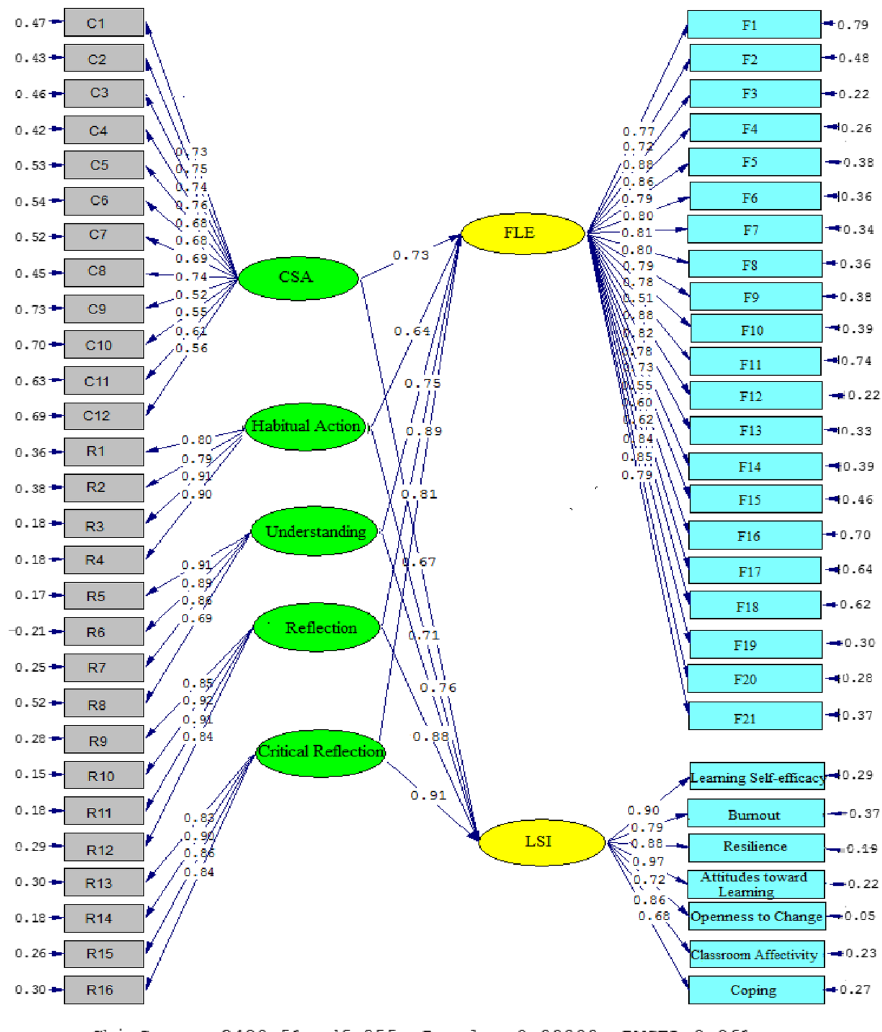
Fig. 4 Schematic representation of path coefficient values for the relationships between CSAQ, RTQ, FLES, and LSIS subscales (model